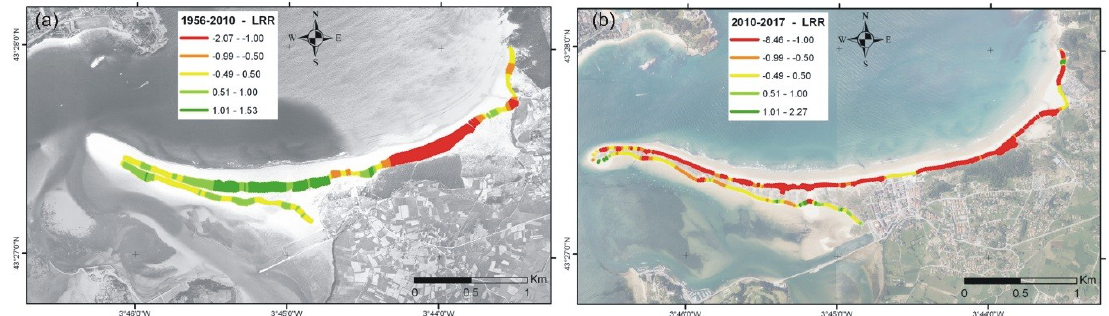
Figure 4. DSAS results for the Linear Regression Rate (LRR) statistical parameter (m year − 1 ) at the Somo-Loredo dune system, for the pre-storm ( a ) and post-storm periods ( b ).